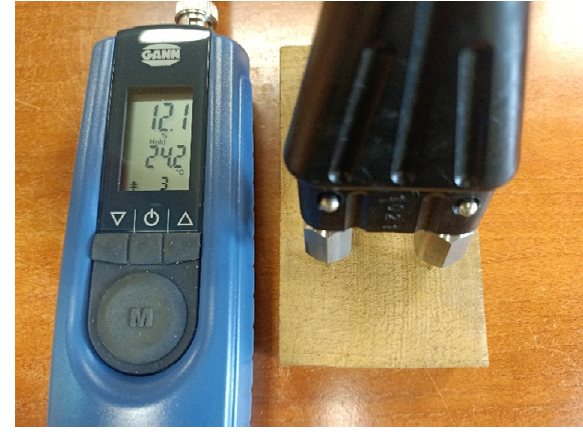
Figure 6. Moisture content control (12%) prior to friction test.